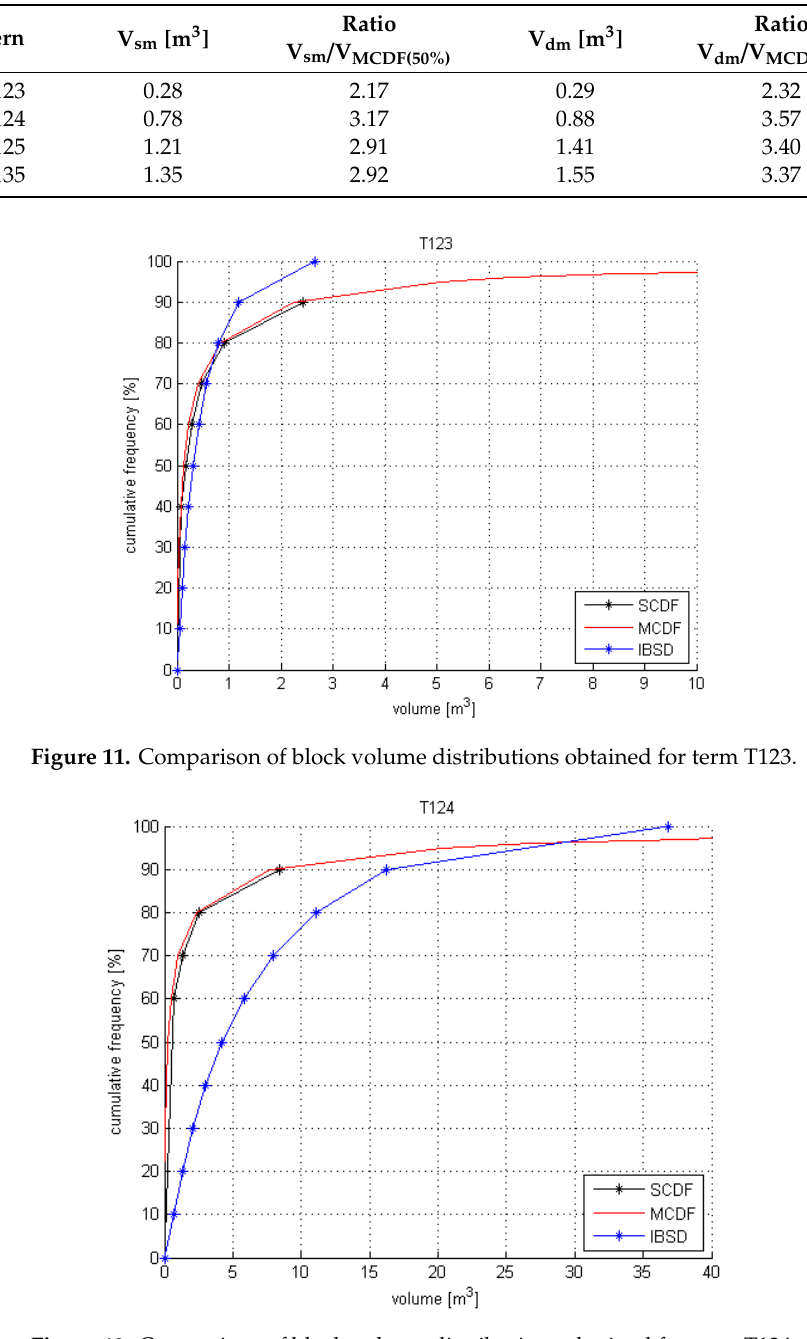
Figure 12. Comparison of block volume distributions obtained for term T124.